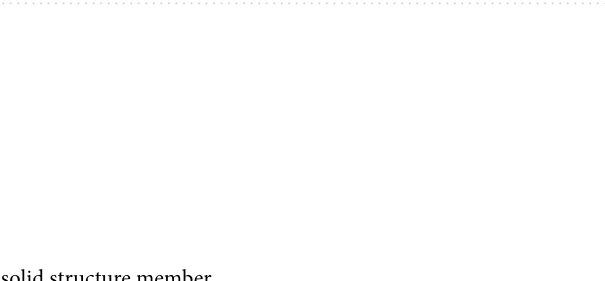
Table 1. Characteristics of single soft skin-solid structure